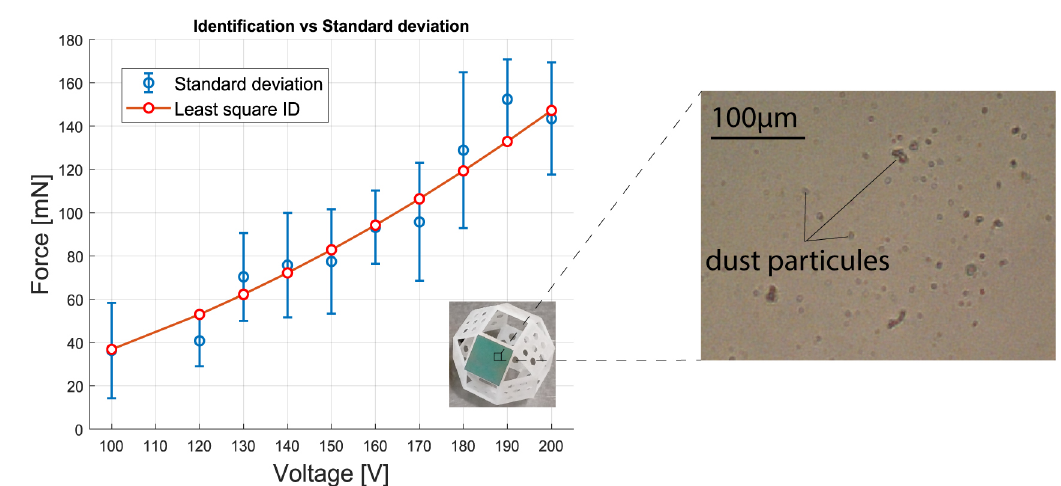
Figure 11. Standard deviation curve versus least square identification